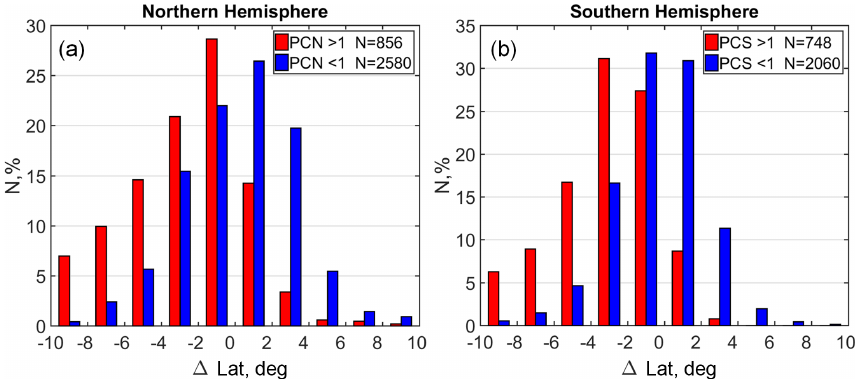
Figure 5. The distribution of (cid:49) Lat for PC > 1 (red bins) and < 1 (blue bins) for the Northern Hemisphere (a) and Southern Hemisphere (b) . N shows the number of events under described